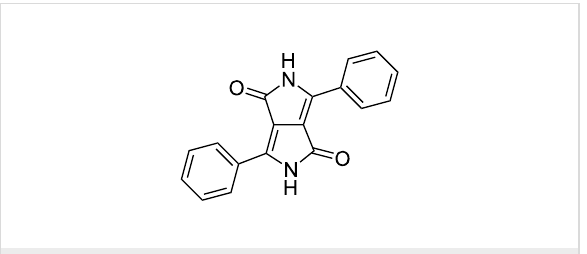
Figure 1: Structure of 3,6-diphenyl-substituted 2,5-diketopyrrolo- [3,4-c]pyrrole (DPP).